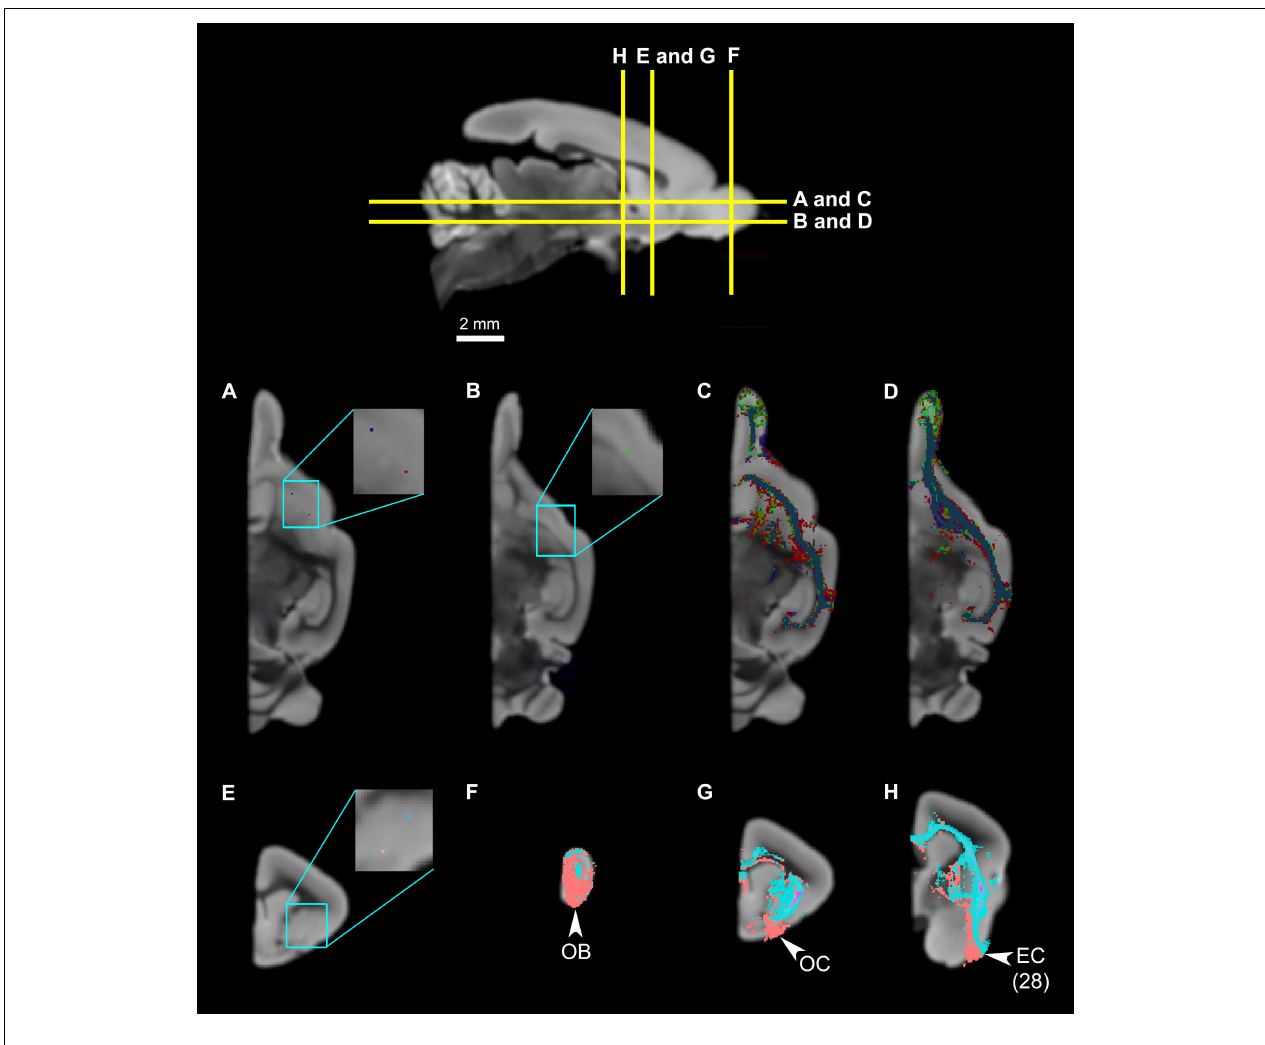
claustrum, and the pink seed in the ventral claustrum. (F,G) Claustrual connections to the olfactory bulb, olfactory cortex, and entorhinal cortex. Note that the tracts from the ventral seed (pink) occupy larger and more ventral portions of the three structures compared to those from the dorsal seed (light blue). Abbreviations: AC, anterior commissure; AN, anterior olfactory nucleus; CL, claustrum; EC, entorhinal cortex, Area 28 in Le Gros Clark’s (1931) cortical map; GP, globus pallidus; OB, olfactory bulb; OC, olfactory cortex; OTR, olfactory tract; OTU, olfactory tubercle; PU,